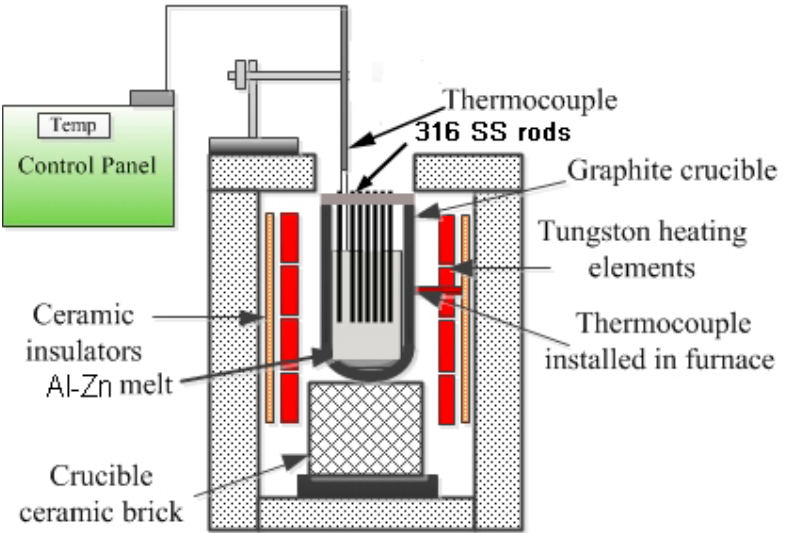
Figure 2. Schematic of the resistant pot furnace used in this study.